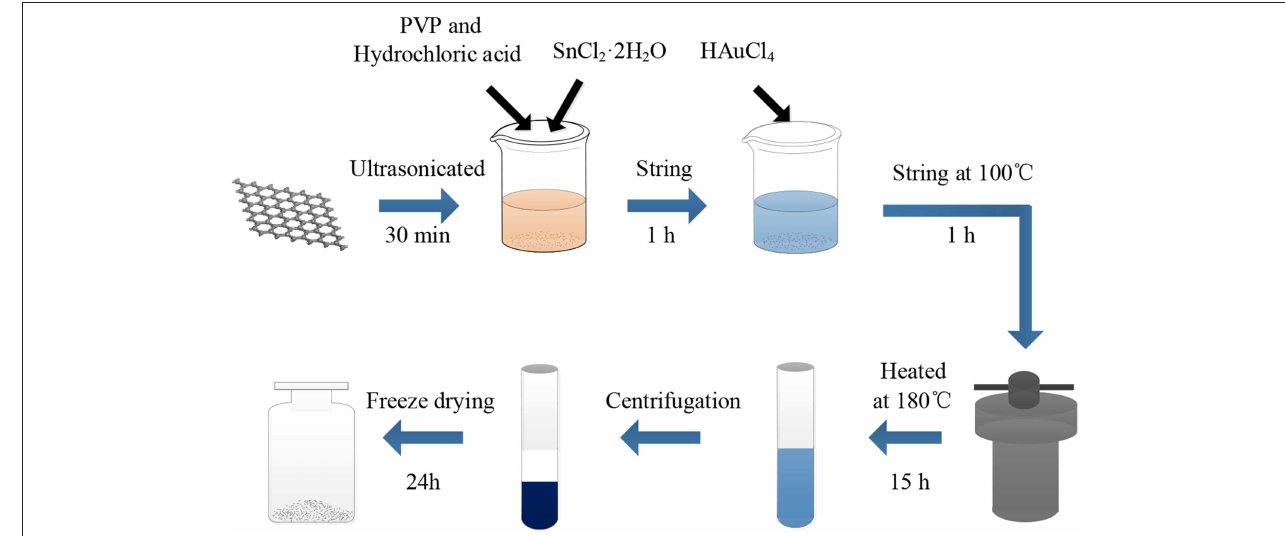
FIGURE 1 | Schematic diagram of the preparation of AuNPs-SnO 2 -RGO hybrid.